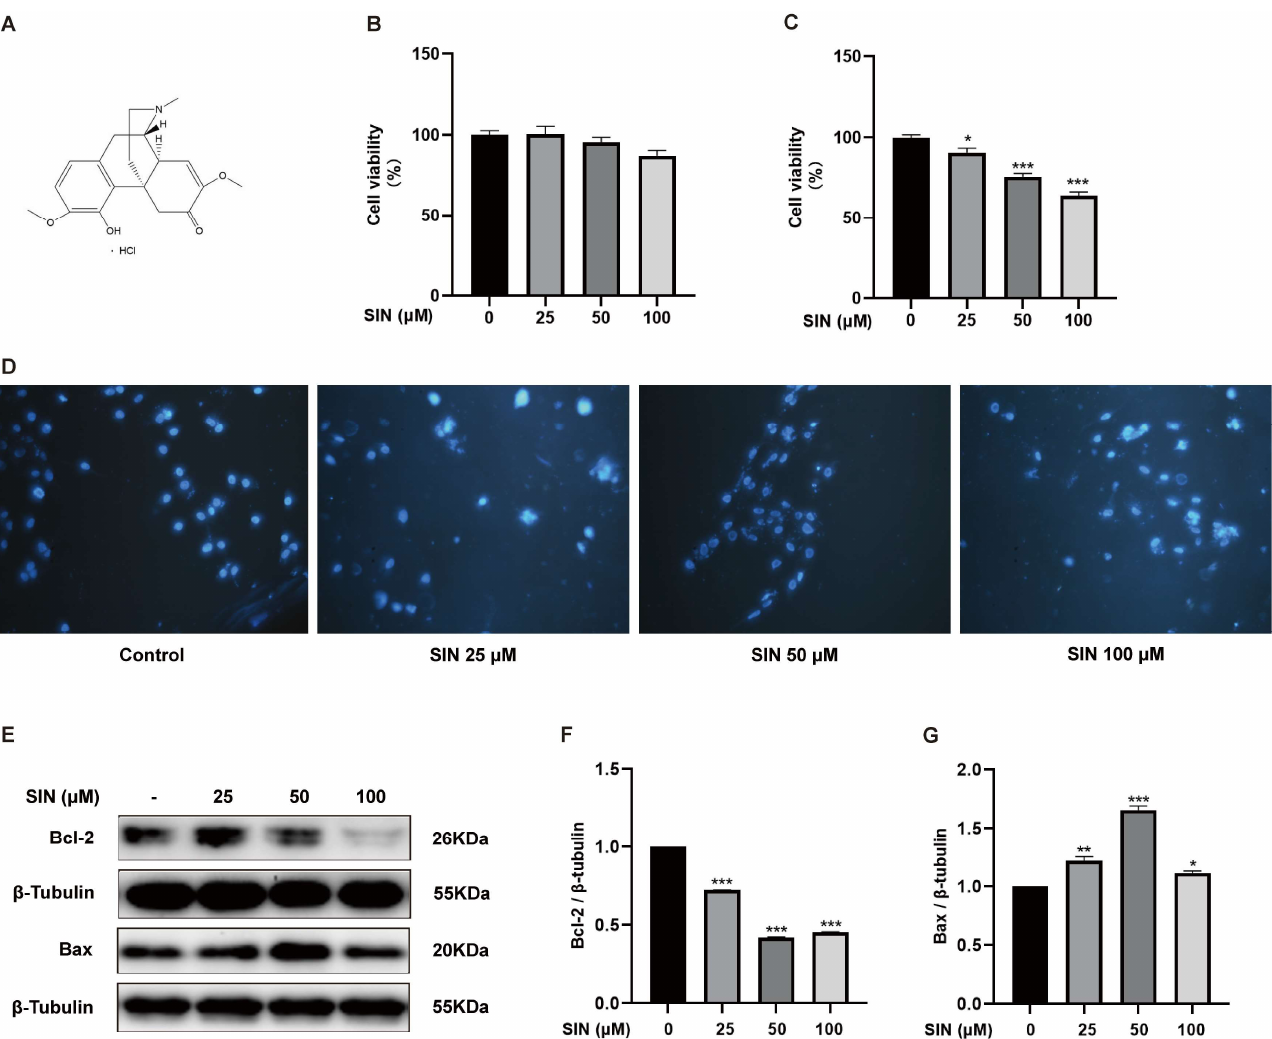
Figure 1. Effect of SIN on BPH-1 cell apoptosis. ( A ) Chemical structure of SIN. ( B ) Effects of SIN on RWPE-1 cell viability. ( C ) Effects of SIN on BPH-1 cell viability. ( D ) Representative images of DAPI- stained cells were observed under a fluorescence microscope. ( E ) Effects of SIN on the expression of apoptosis-related proteins. Protein quantification for ( F ) Bcl-2, ( G ) Bax versus β -tubulin. Data are the mean ± SEM. Statistics: * p < 0.05, ** p < 0.01, *** p < 0.001 versus the control group. SIN, sinomenine hydrochloride; Bcl-2, B-cell lymphoma-2; Bax, BCL2-associated X protein.